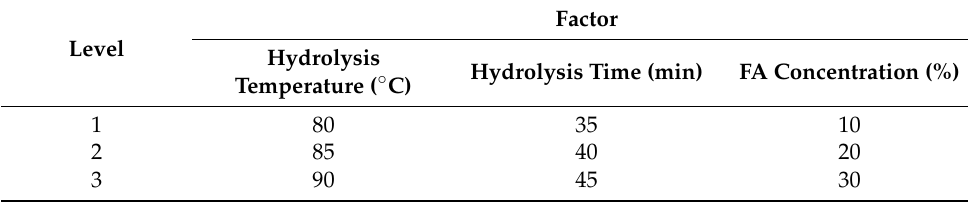
Table 1. Chicken broth pretreatment orthogonal